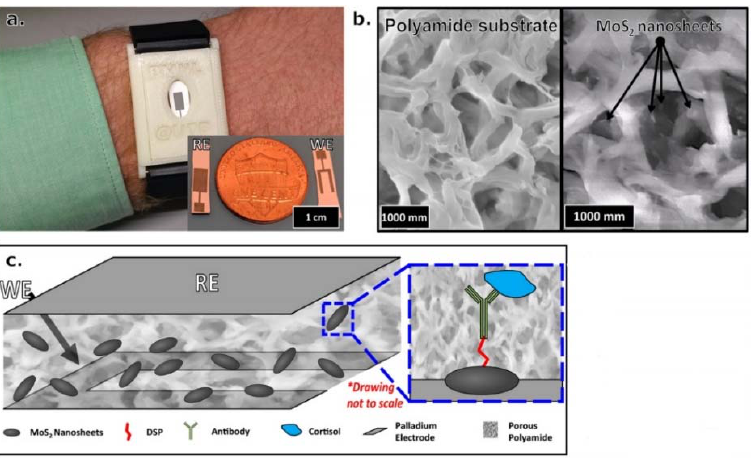
Figure 2. ( a ) Visualized wristband device prototype for monitoring cortisol in human sweat. ( b ) Scanning electron microscope (SEM) image of blank polyamide membrane on the left side, where MoS2 nanosheets were placed into porous polyamide membrane on the right side. ( c ) Stack of MoS2 nanosheets within a polyamide membrane sensing platform for cortisol detection. The blue box is a magnified picture of a nanosheet that presents the affinity assay for cortisol. Reproduced from Kinnamon et al. [38].